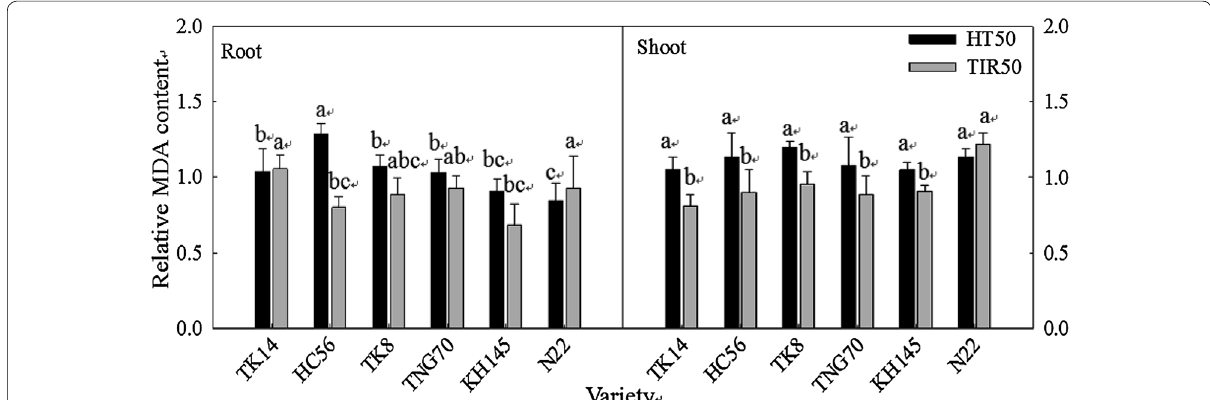
Fig. 11 Relative MDA content in the roots and shoots of rice seedlings grown using the wrapping method under HT50 and TIR50; different letters above the same color bars indicate a significant difference at the 0.05